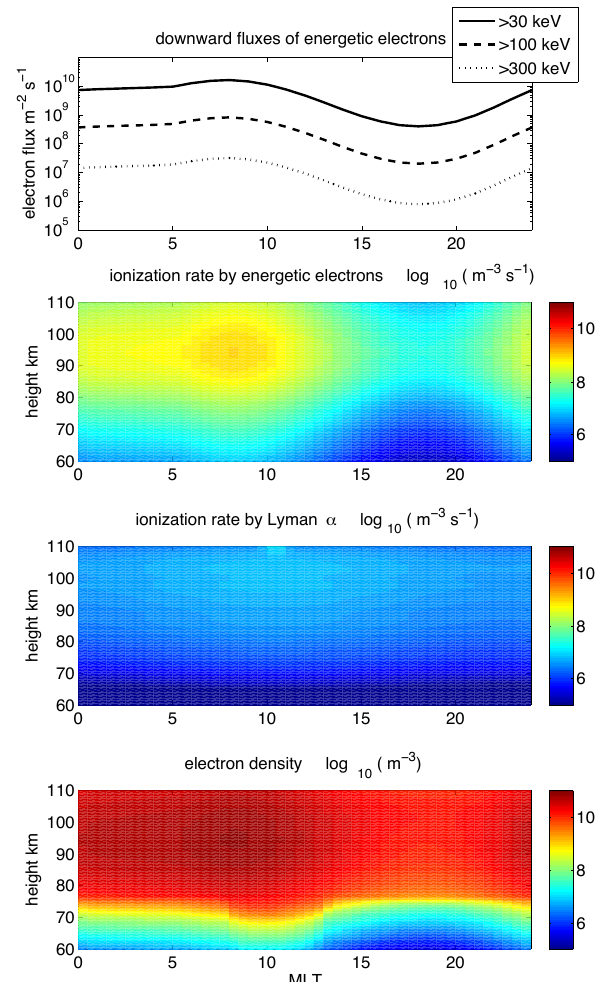
Figure 1. Example model calculations for winter solstice, for the lo- cation of Maitri Station, Antarctica, at geomagnetic latitude 63 ◦ S, geographic latitude 71 ◦ S. Top panel: input fluxes of energetic elec- trons, corresponding to the UQ-HSS model in Table 1. Second panel: ionization rate by energetic electrons. Third panel: ioniza- tion rate of NO by solar Lyman α radiation, including nightglow. Fourth panel: resulting electron density. Timescale is in magnetic local time (MLT). Local solar noon is at 10:04MLT.